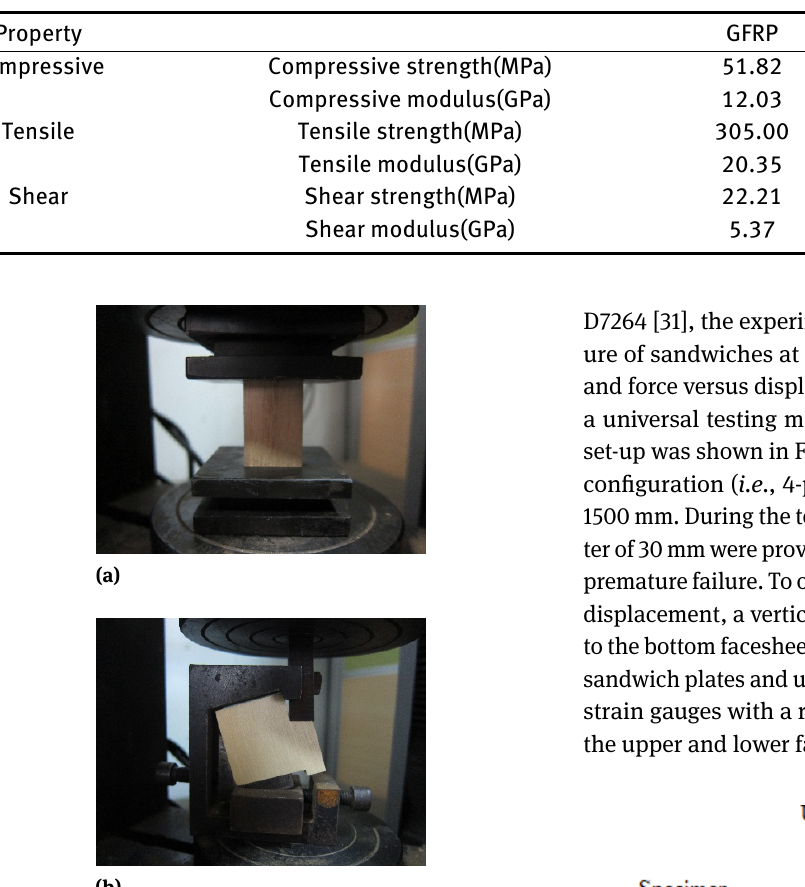
Table 1: Mechanical properties of GFRP ply and paulownia wood core.